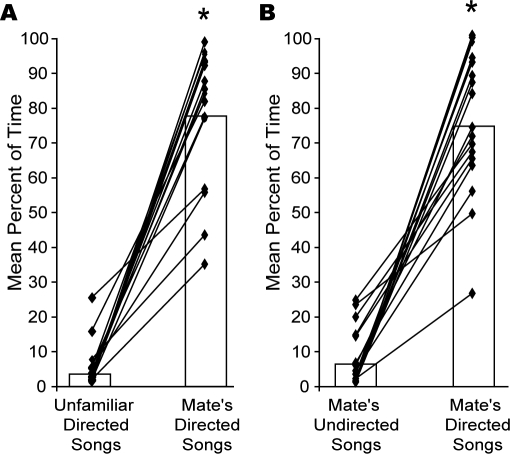
Females Prefer the Directed Songs of Their Mate(A) Mean percent of time spent in the unfamiliar directed and mate's directed song chambers. Individuals are plotted as diamonds. Females spent significantly more time in the mate's directed song chamber (*p < 0.05).(B) Mean percent of time spent in the mate's undirected and directed song chambers. Individuals are plotted as diamonds. Females spent significantly more time in the directed song chamber (*p < 0.05).